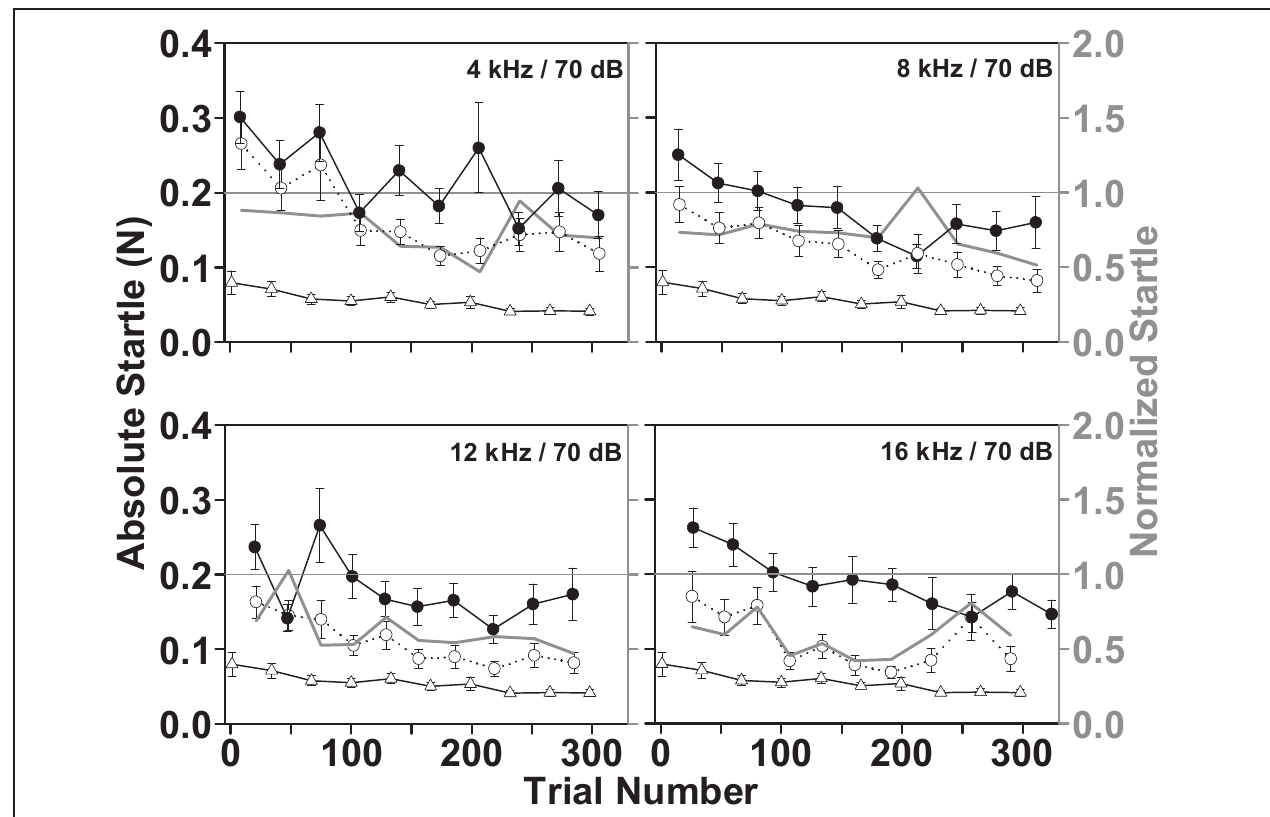
responses to a startle pulse without preceding gap; white circle graphs are the responses when the startle pulse follows a 15ms gap, white triangle graphs indicate the background movement of the animal in intermingled trials without sound presentation (left Y axis). The gray line graphs plot the normalized startle response (startle “with gap”/startle “without gap”; right Y axis with gray labels) derived from the mean startle responses of all days of all animals.